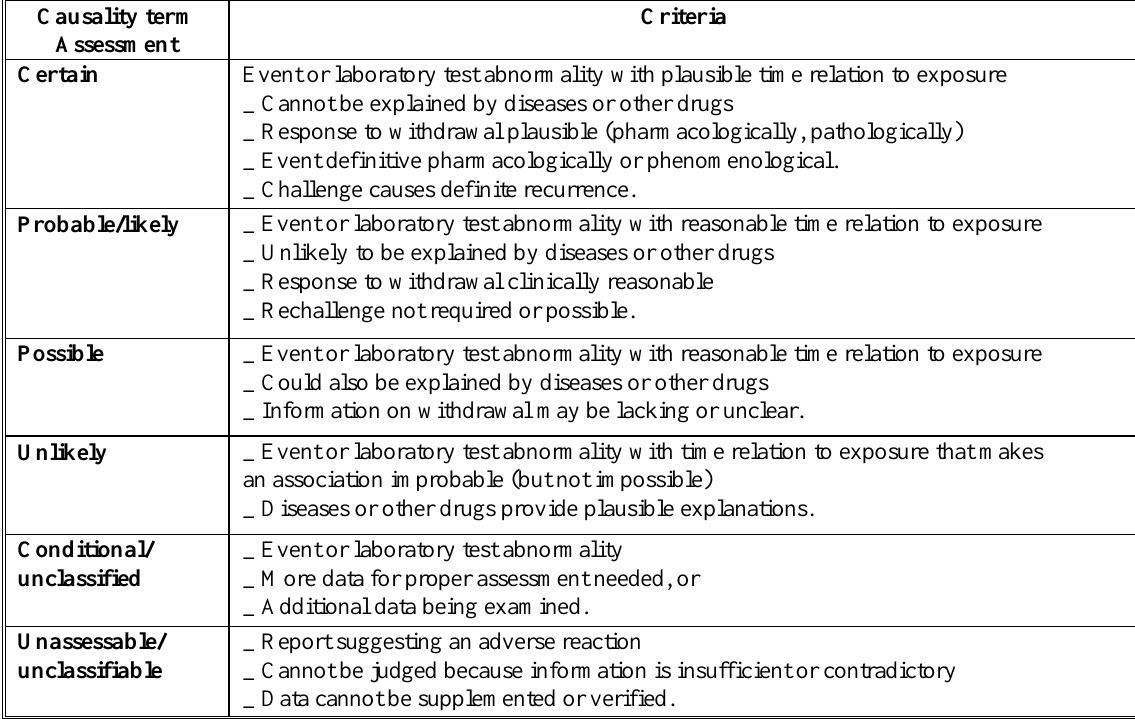
Table 1. The WHO-UMC criteria for causality assessment